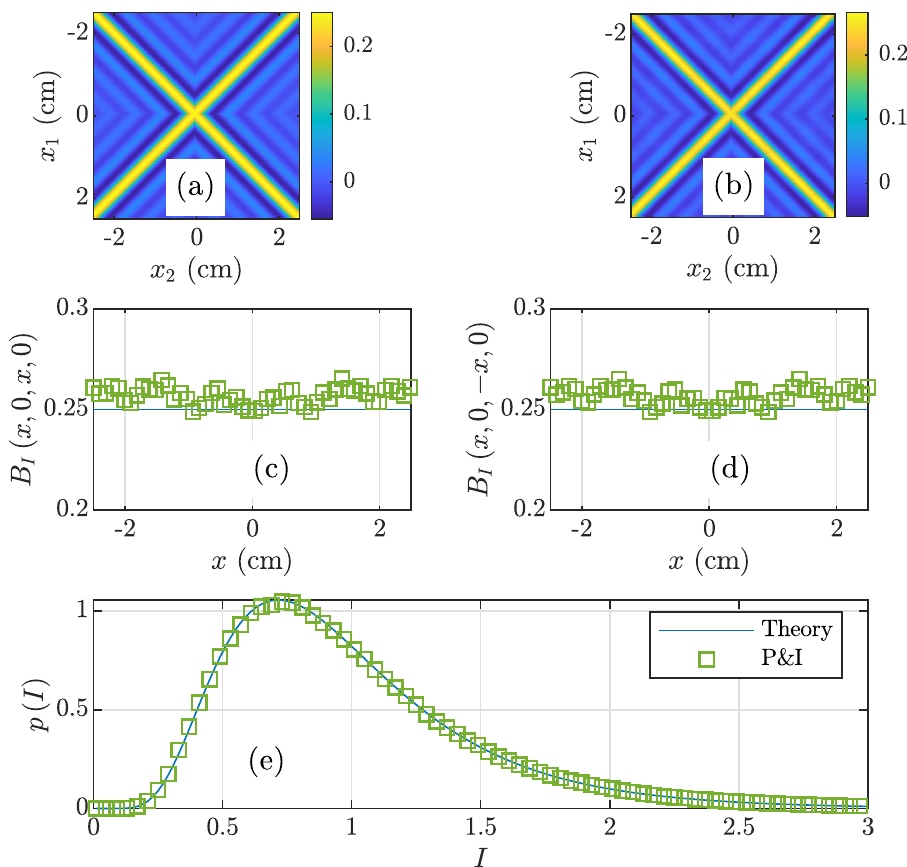
Figure 6. NUC beam irradiance results—( a ) theory and ( b ) P&I B I ( x 1 ,0, x 2 ,0 ) ; ( c ) theory and P&I B I ( x ,0, x ,0 ) ; ( d ) theory and P&I B I ( x ,0, − x ,0 ) ; and ( e ) theory and P&I irradiance PDFs. The P&I field expression is given in Equation (2). The theoretical irradiance PDF and covariance of irradiance are given in Equations (34) and (36),